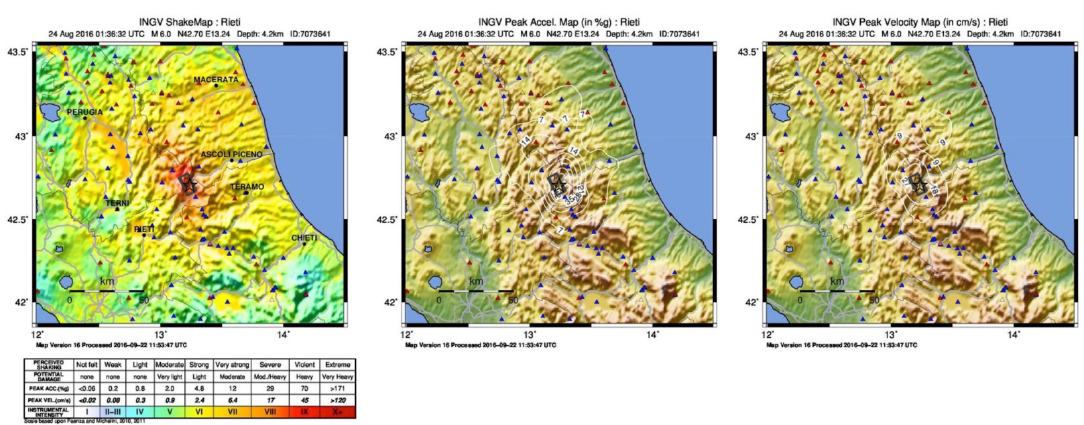
Figure 3. The Shakemaps of the main shock using the revised data obtained from the engineering strong motion DB (http://esm.mi.ingv.it). Left: MCS derived instrumental intensity; Center: PGA; Right: